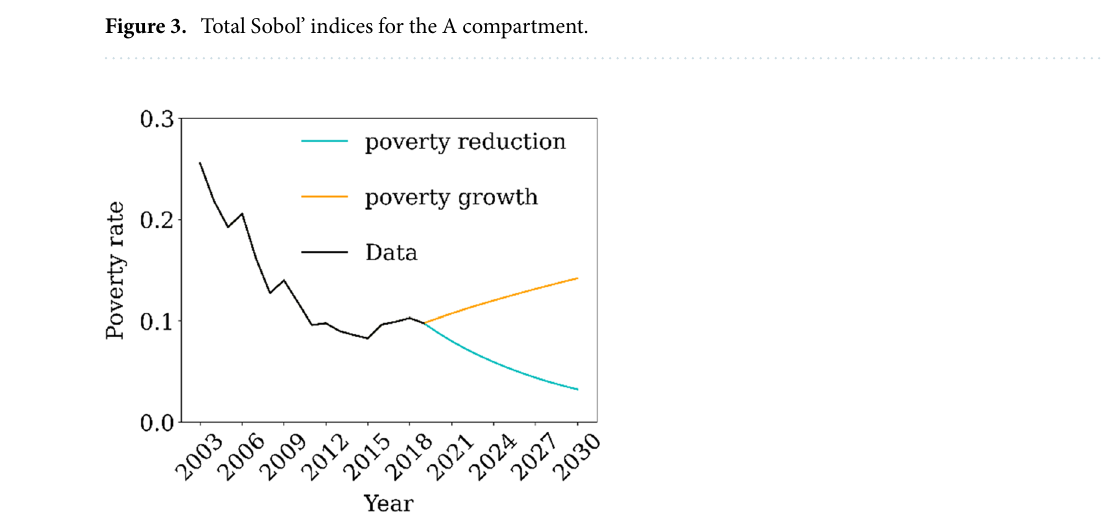
Figure 4. Poverty rate scenarios between 2003 and